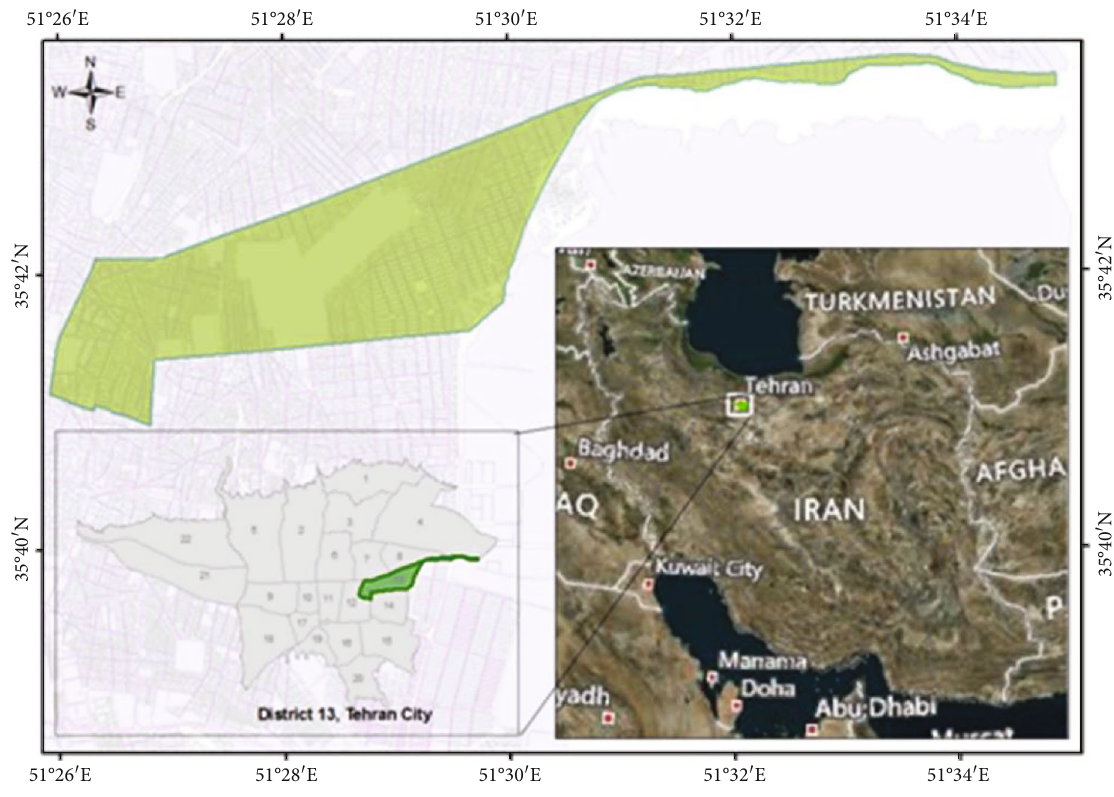
Figure 2: Location of the study